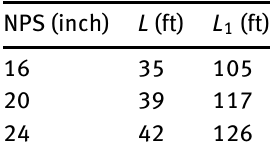
Table 3: Anchor and guide distance.